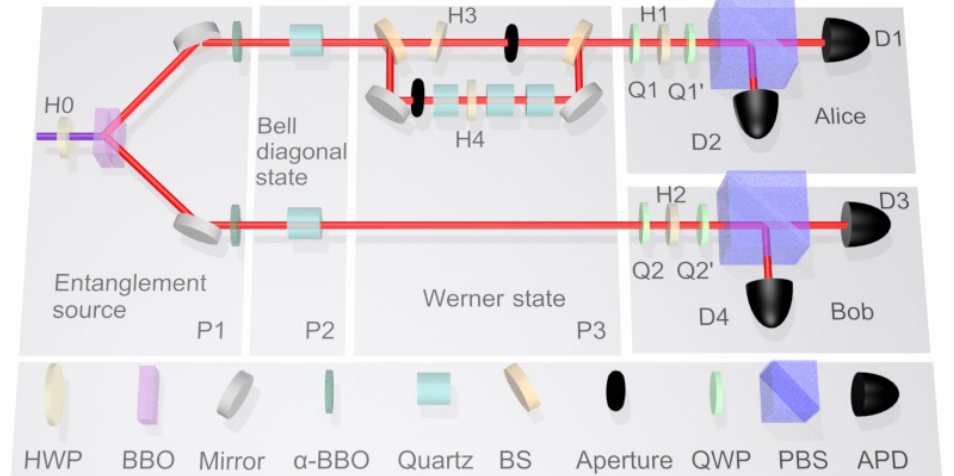
Figure 2. Experimental setup. The experimental setup can be divided into a state preparation module and measurement module. The maximally polarization-entangled photon pairs are generated via type-I spontaneous parametric down-conversion process on platform P1. On this basis, the platform P2 is used to prepare arbitrary Bell diagonal states ρ b and platform P3 is used to prepare arbitrary Werner states ρ w . In the measurement setup, the observables Alice and Bob carried out in our whole experiment are realized by a combination of sandwich-type QWP-HWP-QWP sequences and following PBS. All the joint probabilities can be read out from the coincidence between certain